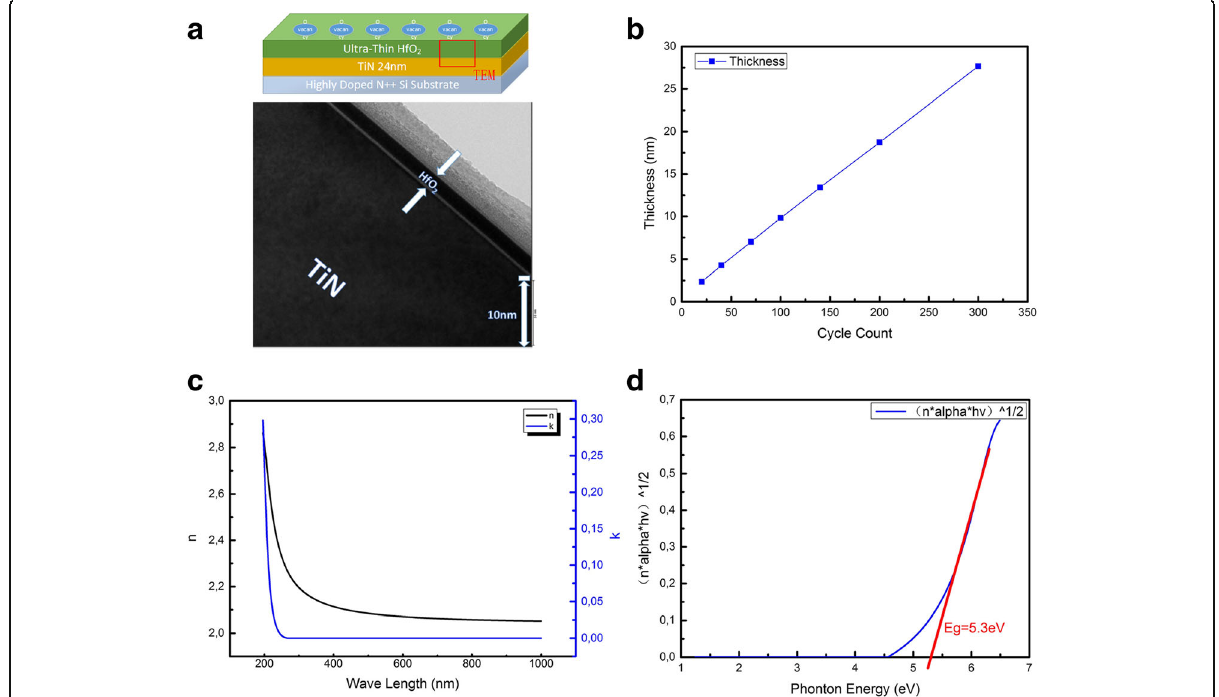
Fig. 1 Material characterization. a Structure and TEM images of HfO 2 /TiN/Si structure. b Growth rate measurement of HfO 2 . c Optical constant of